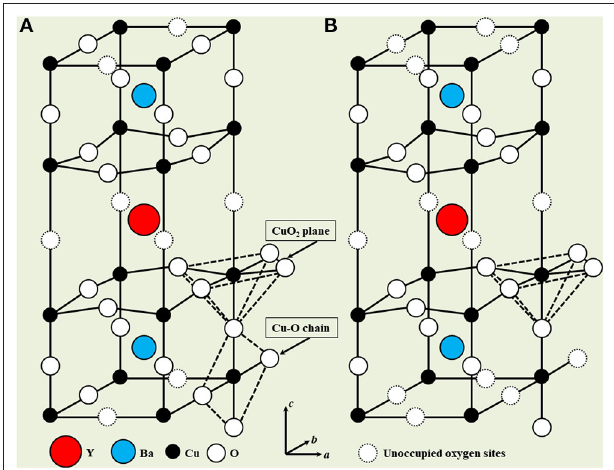
FIGURE 4 | The crystal structure of YBa 2 Cu 3 O 7 δ for (A) δ = 0 (YBa 2 Cu 3 O 7 ) − when all of the oxygen sites in the basal planes along the b- direction are occupied and for (B) δ 1 (YBa 2 Cu 3 O 6 ) when all these sites are unoccupied. = The intermediate oxygen contents are achieved as these sites are partially occupied when the sample is annealed in oxygen atmosphere. The crystal structure is tetragonal for δ 0.6 and orthorhombic for δ < ≥